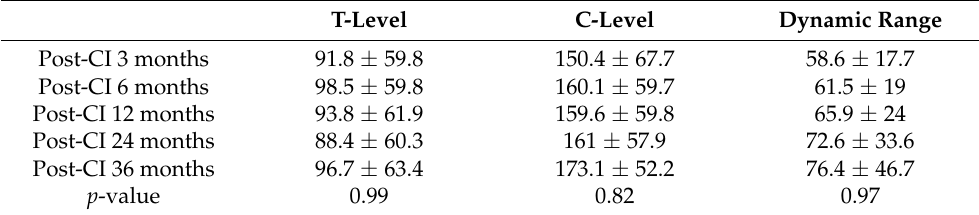
Table 3. Comparison of T-level, C-level, and dynamic range at postoperative 3, 6, 12, 24, and 36 months in patients with bilateral CN